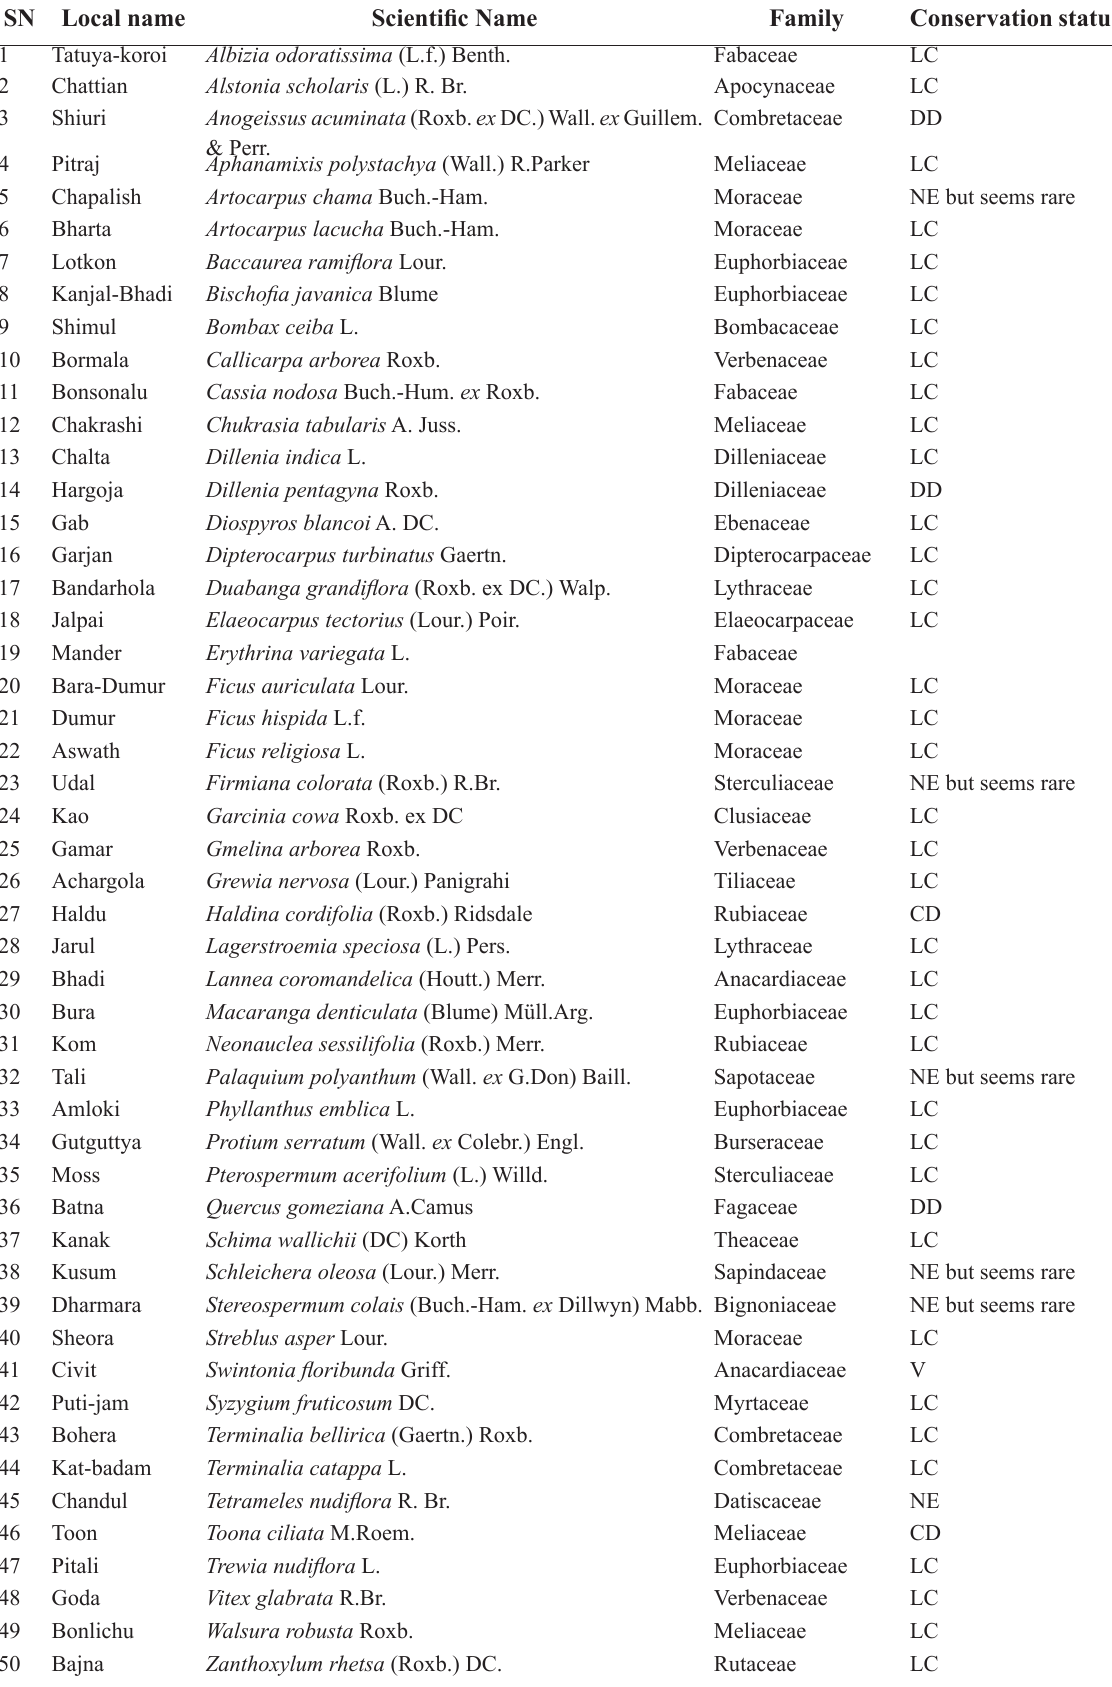
Table 2: List of tree species recorded from Rampahar Forest Reserve. [Here, CD = Conservation Dependent, DD = Data Deficient, LC = Least Concern, NE = Not Evaluated, V =